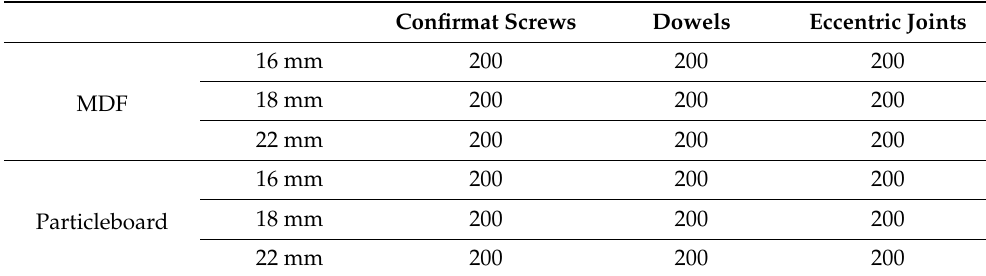
Table 1. The number of testing samples made of various materials, connectors, and thickness of the elements of the furniture joints.